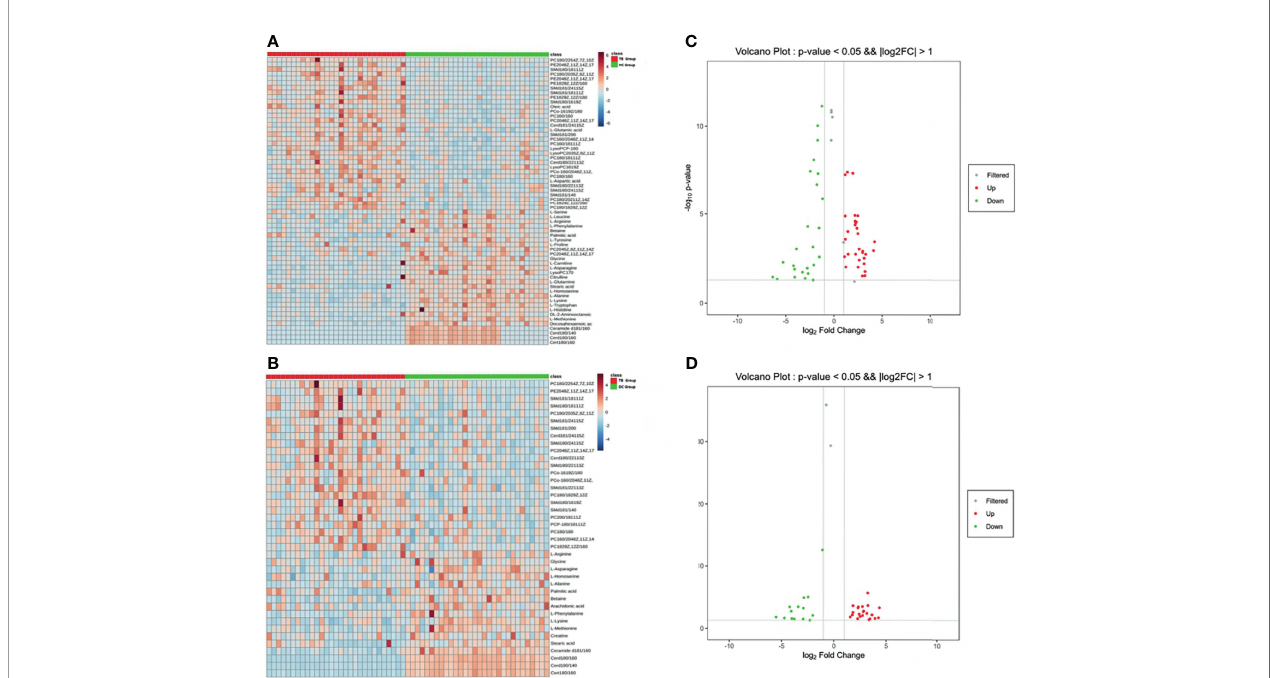
FIGURE 2 | Heat maps and volcano maps of metabolites. (A) Heat map of TB group vs. HC group; (B) volcano map of TB group vs. HC group (C) heat map of TB group vs. DC group; (D) volcano map of TB group vs. DC group.